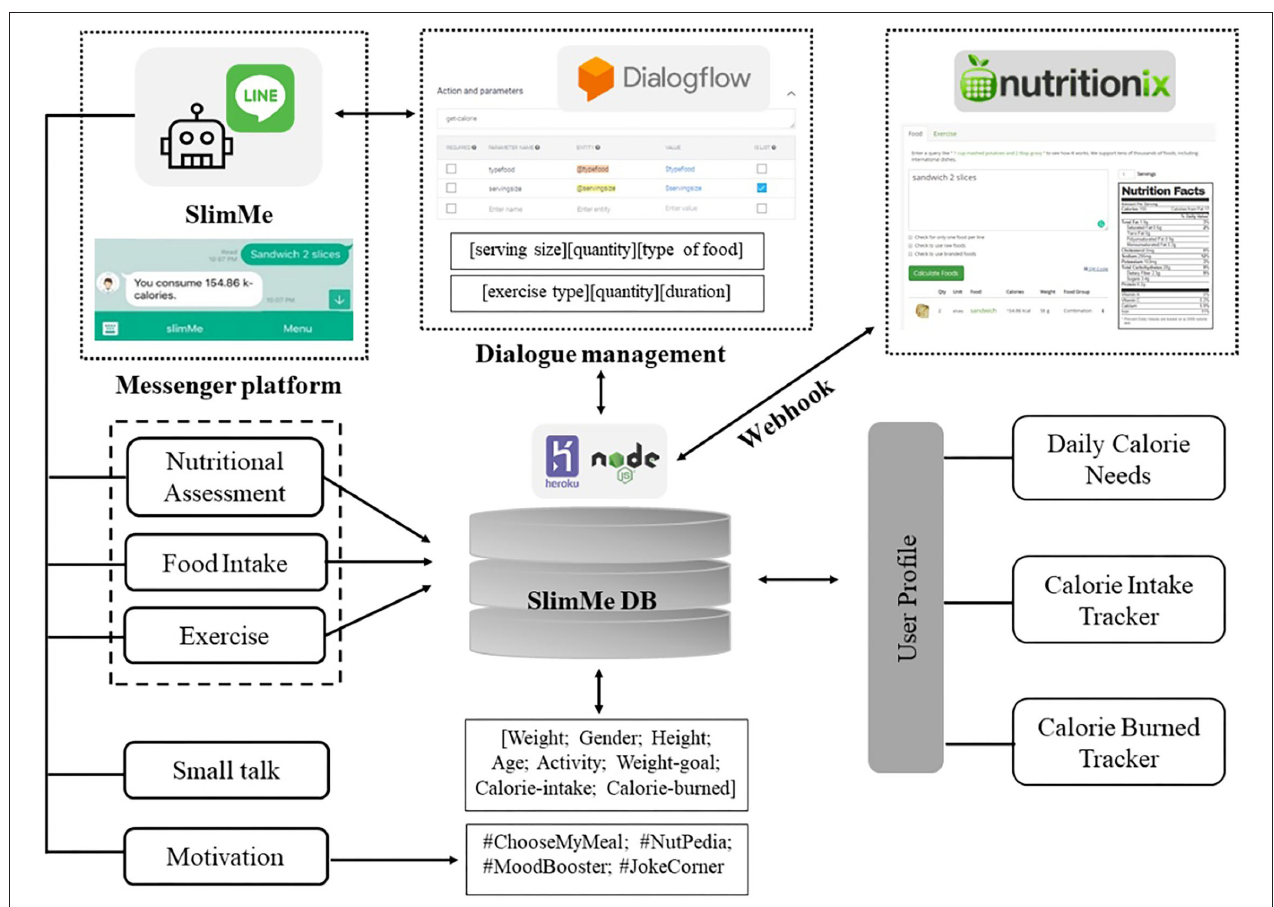
FIGURE 1 | SlimMe architecture and knowledge-based